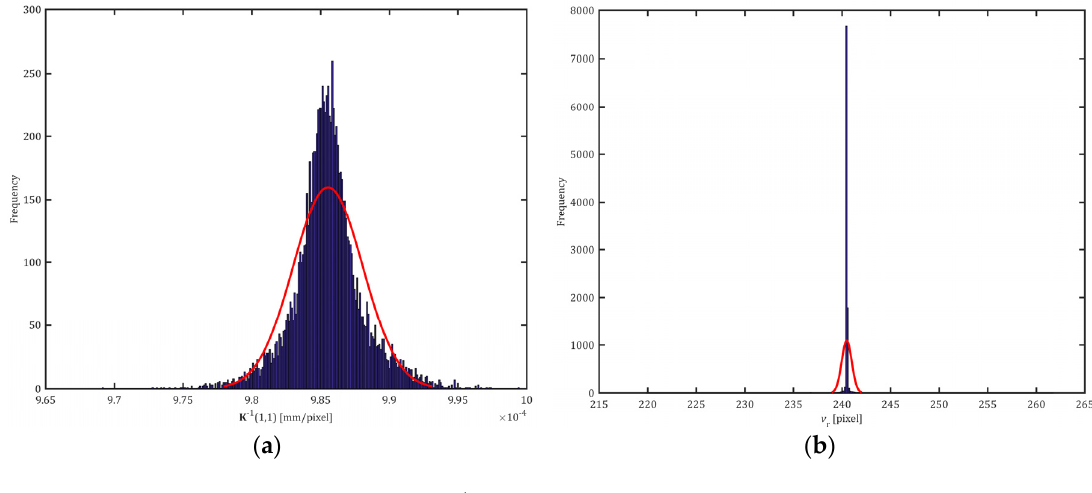
Figure 1. ( a ) K − 1 (1, 1) histogram; ( b ) v r histogram. Figure 1. ( a ) K ´ 1 (1, 1) histogram; ( b ) v r